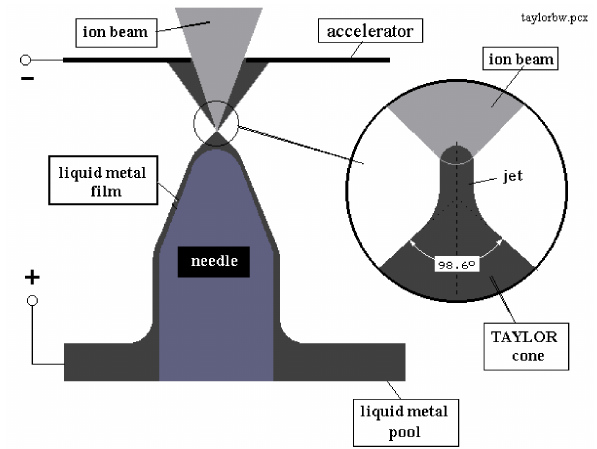
Fig. 2. Schematic plot of the principle of a needle type liquid metal ion